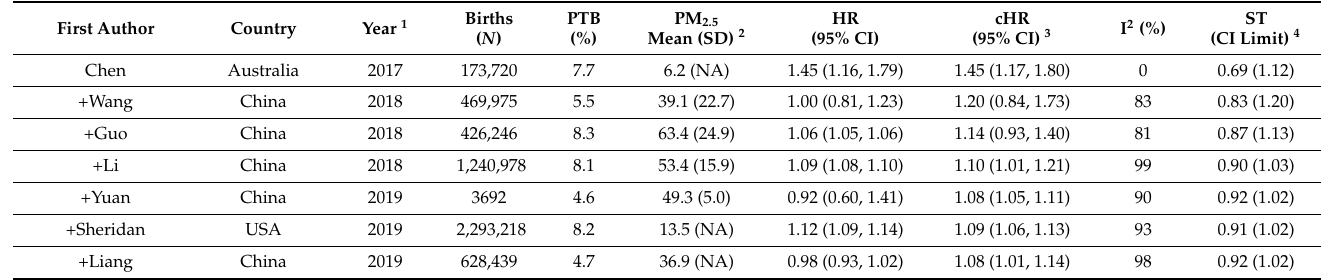
Table 2. Cumulative hazard ratios (cHR) of preterm birth (PTB) per 10 µ g/m 3 increase in